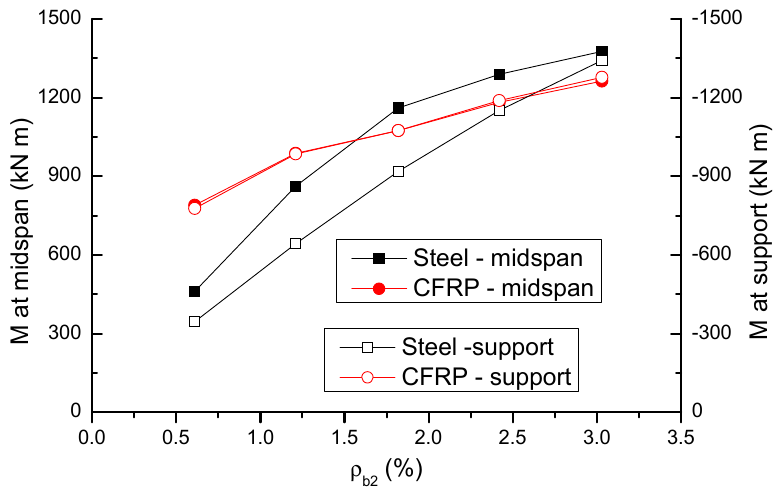
Figure 7. Variation of ultimate moment with varying bar ratio.